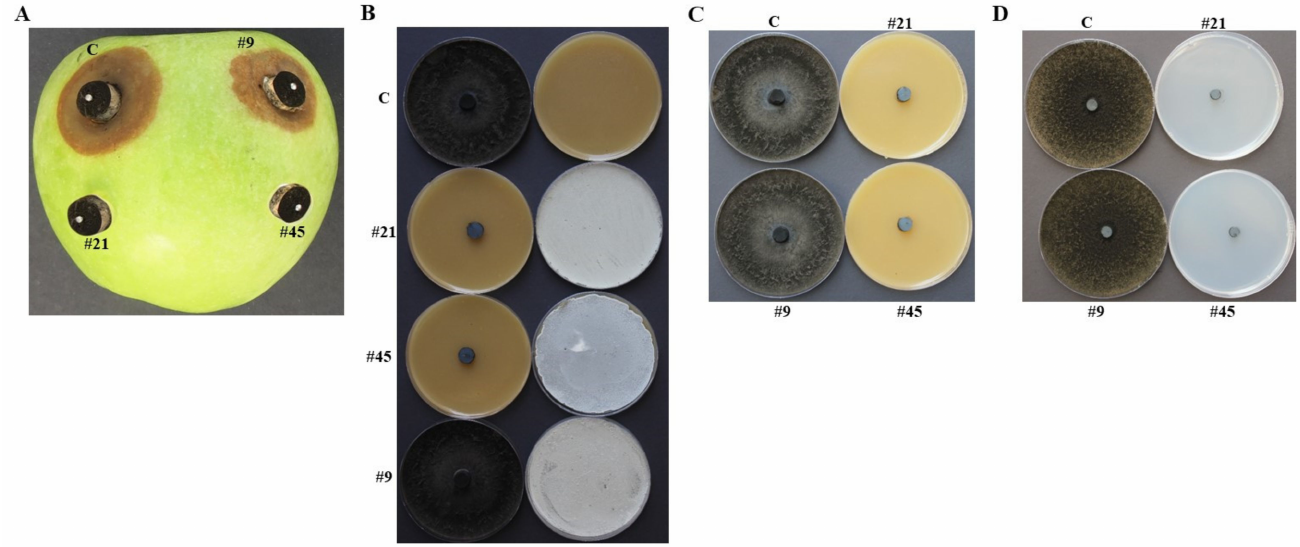
Figure 1. In vivo apple bioassay and in vitro characteristics of BCA candidates against Neoscytalidium dimidiatum . ( A ) Apple fruit bioassay using agar plug combinations of inoculated-apple fruit with BCAs and N. dimidiatum after seven dpi. ( B ) Inhibition of N. dimidiatum mycelial growth by the volatile antifungal compounds-producing isolates #21 (BCA3) and #45 (BCA5) compared to the volatile antifungal compounds-non-producing isolate #9. Dialysis membrane overlay technique using ( C ) FMEA or ( D ) CCA plates. In ( A ), N. dimidiatum inoculum alone with a sterile agar plug below it ( C ); isolate #, the isolate was placed on the apple surface and N. dimidiatum -inoculated plug on top of the isolate. In ( C ), inhibition of N. dimidiatum mycelial growth was observed on FMEA plates colonized by the diffusible antifungal metabolite-producing isolate #21 (BCA3) and #45 (BCA5) compared to the diffusible antifungal metabolite-non-producing isolate #9. In ( D ), inhibition of N. dimidiatum mycelial growth was observed on CCA plates colonized by the chitinase-producing isolates #21 and #45 compared to the chitinase non-producing isolate #9. In ( B – D ), no isolate colonization served as a control ( C ). In ( A – D ), the diffusible antifungal metabolite- and CWDEs-producing isolates #21 and #45 were compared to the non- producing isolate #9. Isolates #21, #45 and #9 represent Streptomyces griseorubens (BCA3), Streptomyces wuyuanensis (BCA5) and Streptomyces sp.; respectively. FMEA, fish meal extract agar; CCA, colloidal chitin agar, dpi, days post inoculation; BCA, biological control